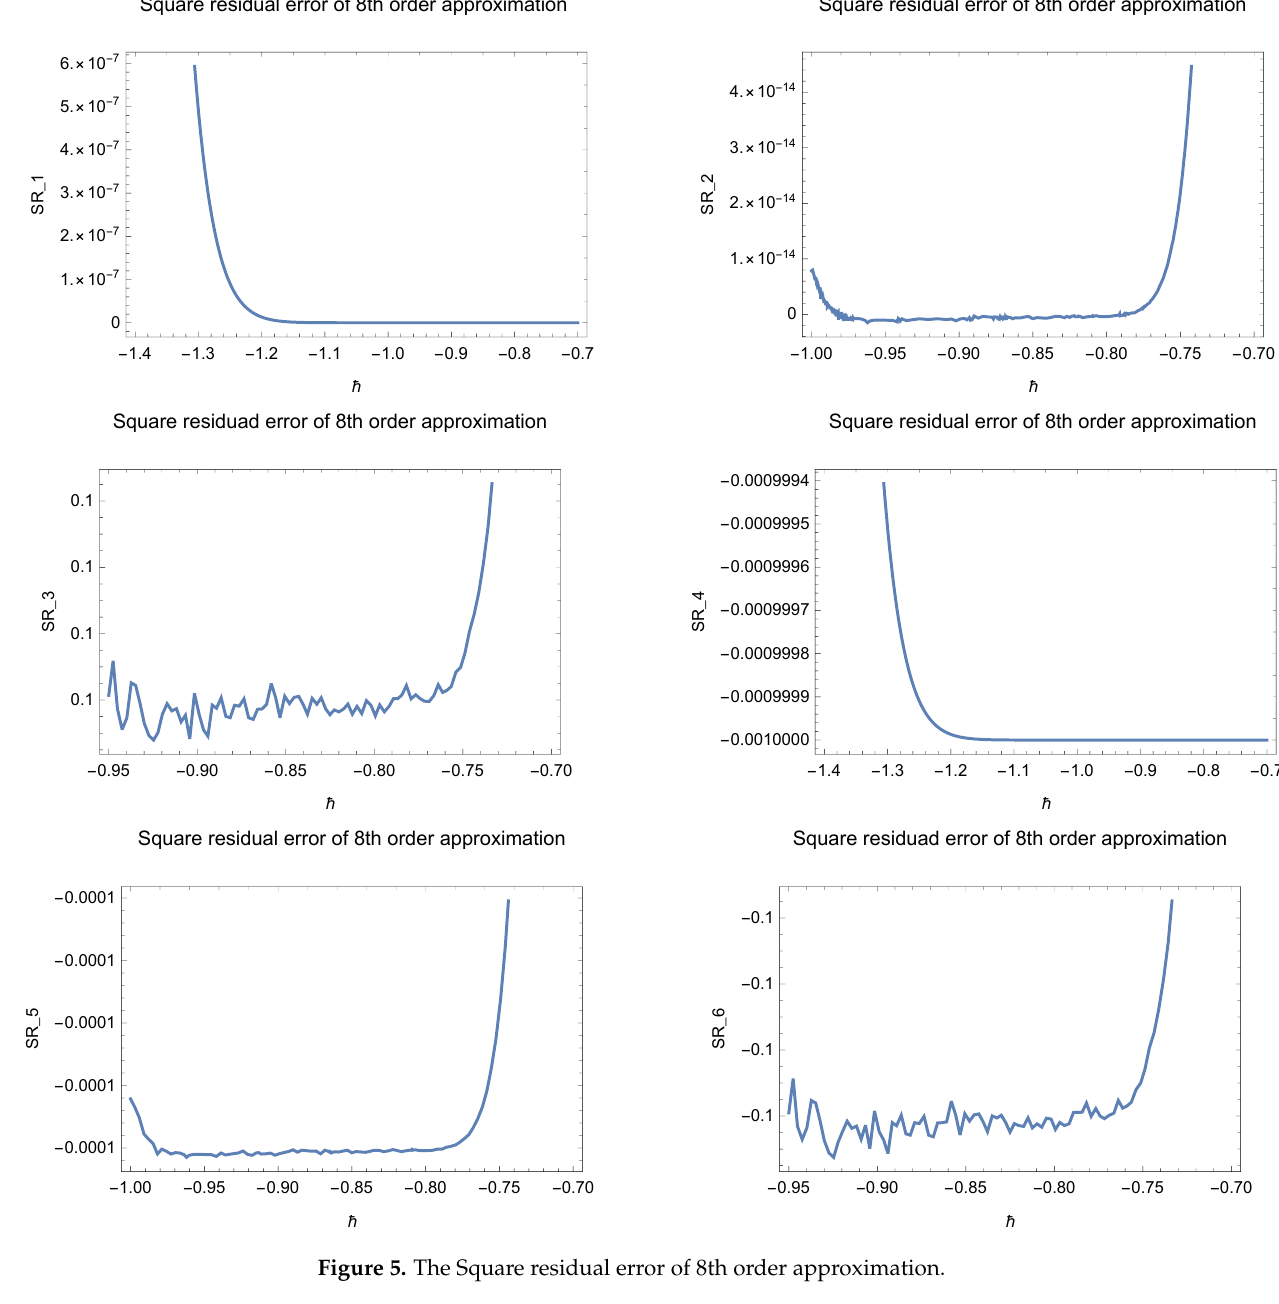
Fig. 5 The Square residual error of 8 th order approximation Figure 5. The Square residual error of 8th order